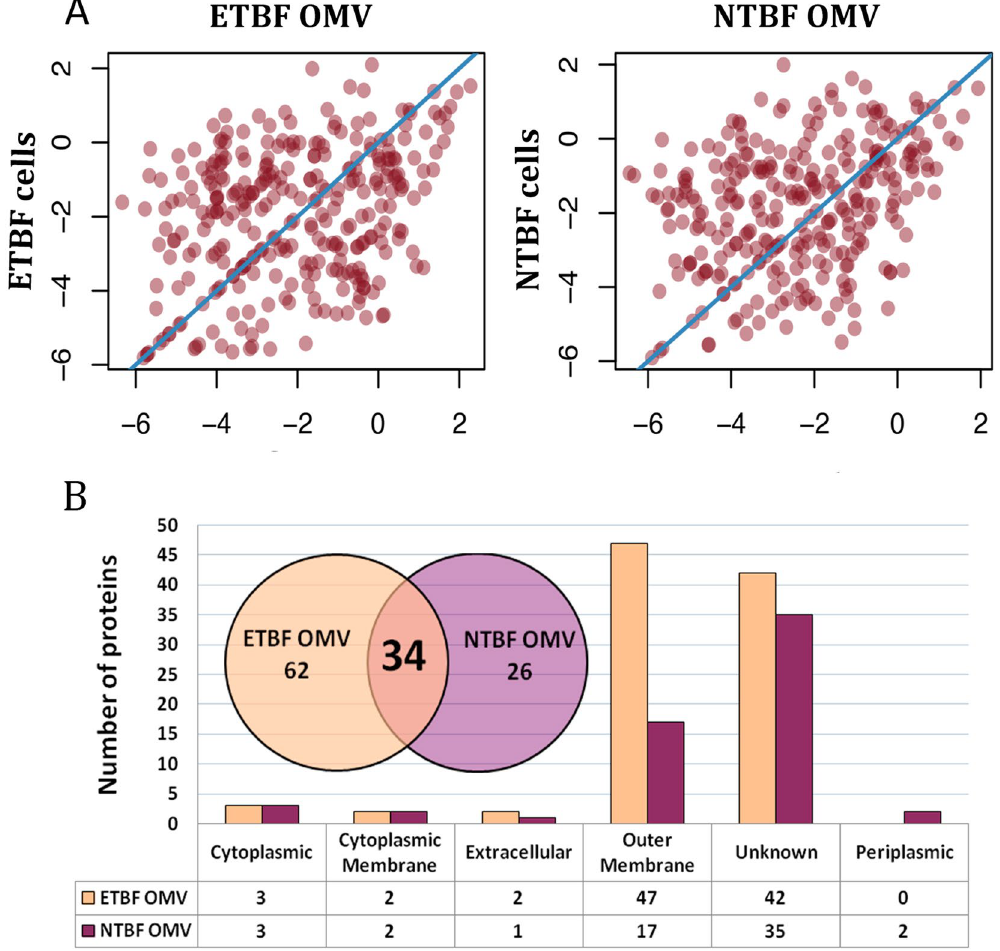
Figure 4. Comparative analyses of ETBF and NTBF proteins identified in B. fragilis cells and OMVs. ( A ) Correlation analysis of the representation of the proteins identified in ETBF/NTBF cells vs. ETBF/NTBF OMVs. Each point indicates emPAI calculated for the proteins identified in both ETBF/NTBF cells and ETBF/ NTBF OMVs. ( B ) Proteins identified exclusively (the proteins were not identified in cells proteome) in ETBF/ NTBF OMVs. The columnar histogram shows ETBF/NTBF OMV protein distribution according to subcellular localization. The Venn diagram describes individual differences in the total number of proteins identified exclusively (the proteins were not identified in cells proteome) in ETBF/NTBF